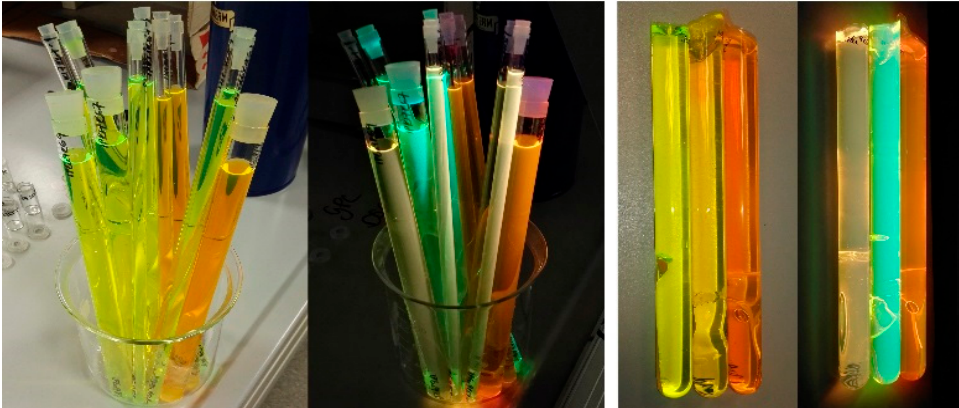
Figure 1. Total absorption and emission bands of the selected hybrid combinations of dopants measured in DCM dissolution. Solid line: absorption. Dotted line: emission.